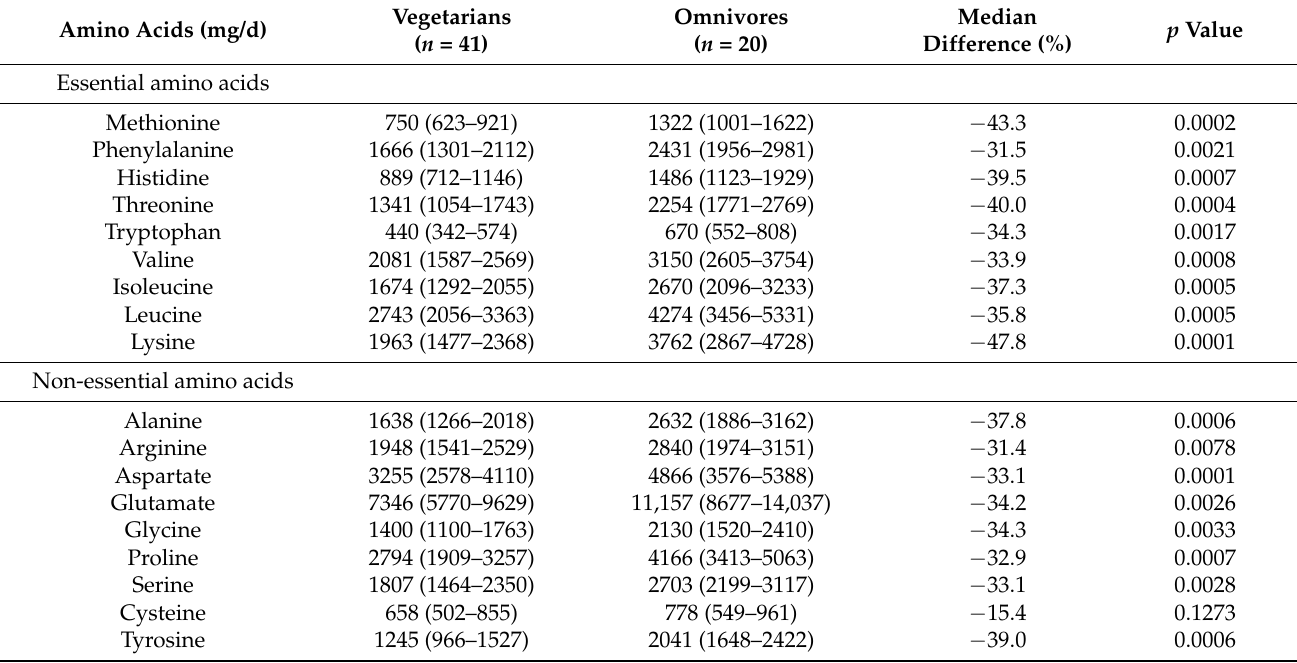
Table 2. Dietary intake of amino acids in children on vegetarian and omnivorous